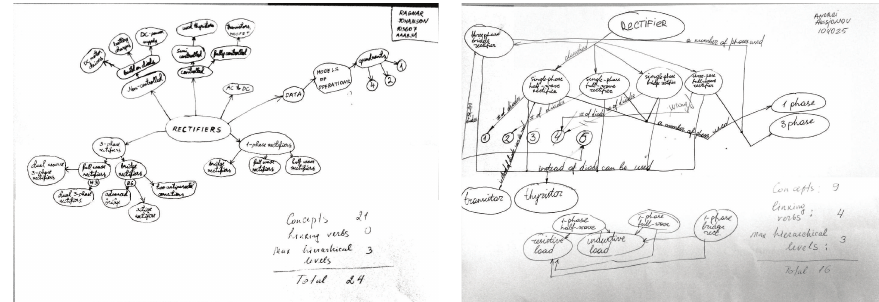
Figure 2: Students’ concept